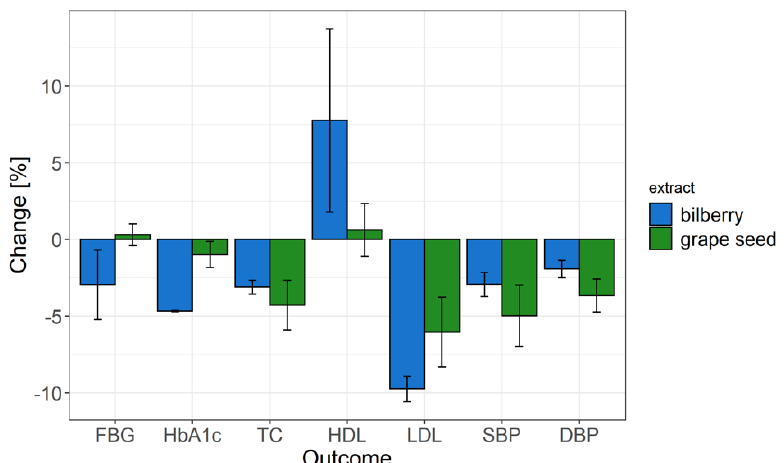
Figure 7. Calculated means and standard errors of percentage changes in study outcomes (FBG— fasting blood glucose, HbA1c—glycated hemoglobin, TC—total cholesterol, HDL and LDL choles- terol, SBP—systolic blood pressure, DBP—diastolic blood pressure) across all intervention studies with bilberry interventions (blue) and grape seed interventions (green).